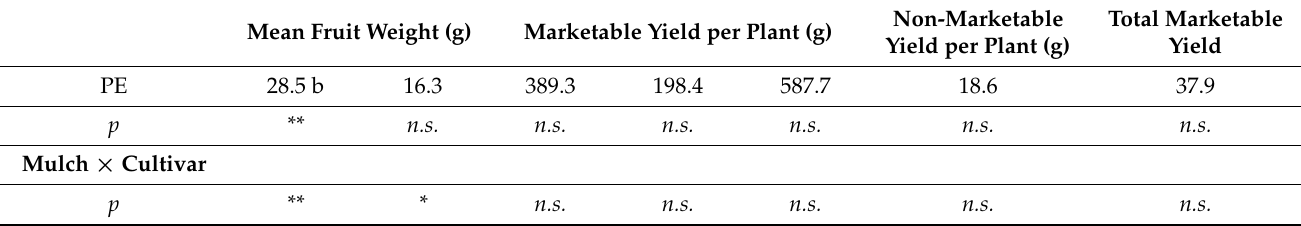
Table 1. Cont. Mean Fruit Weight (g) Marketable Yield per Plant (g)